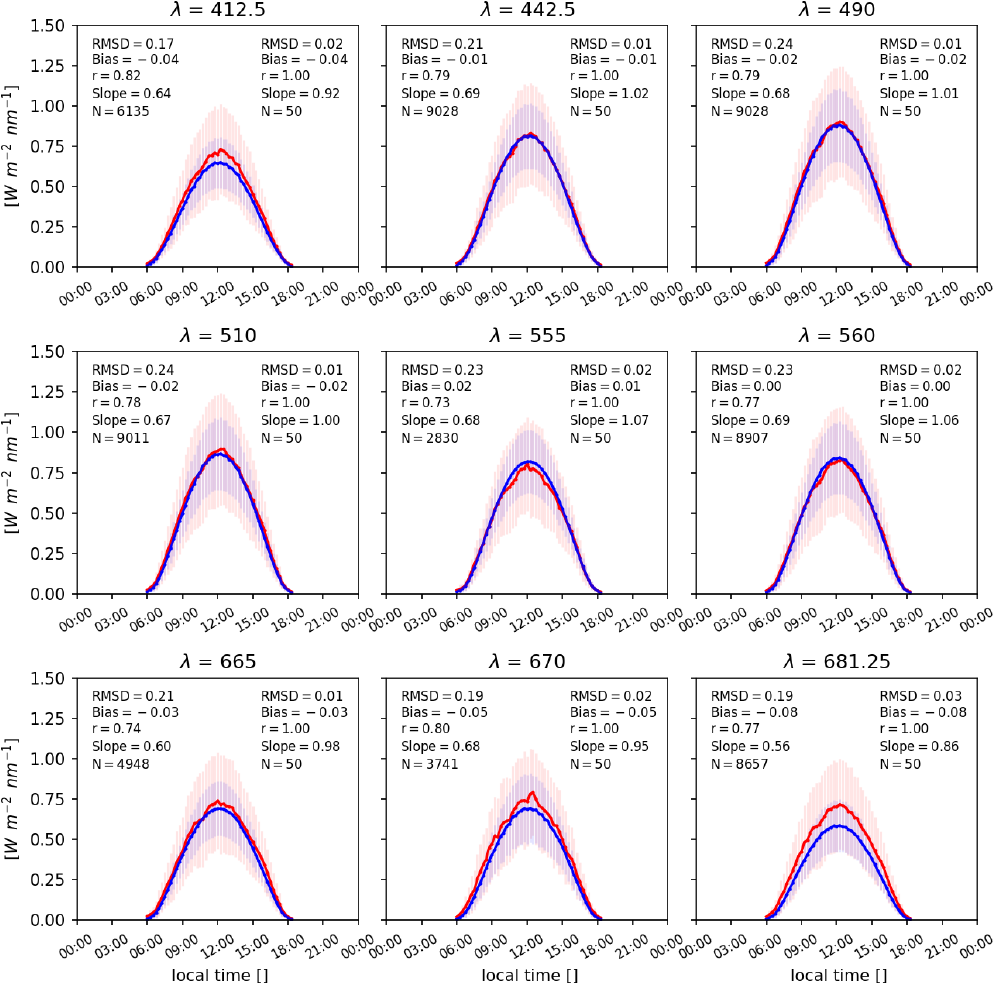
Figure 6. Multispectral downward planar irradiance ( E d (λ 0 − ) ) simulated by OASIM (blue lines) and measured at BOUSSOLE (red lines). The wavelengths considered are those measured by the BOUSSOLE sensors for the average March data derived from the time series. For each panel, the reported statistics (RMSD, bias, r and regression slope) are related both to the high-frequency signal (with a temporal resolution of 15min; top left) and to the average day in the considered month (top right). The vertical bars indicate the variance in the monthly averaged values of the average